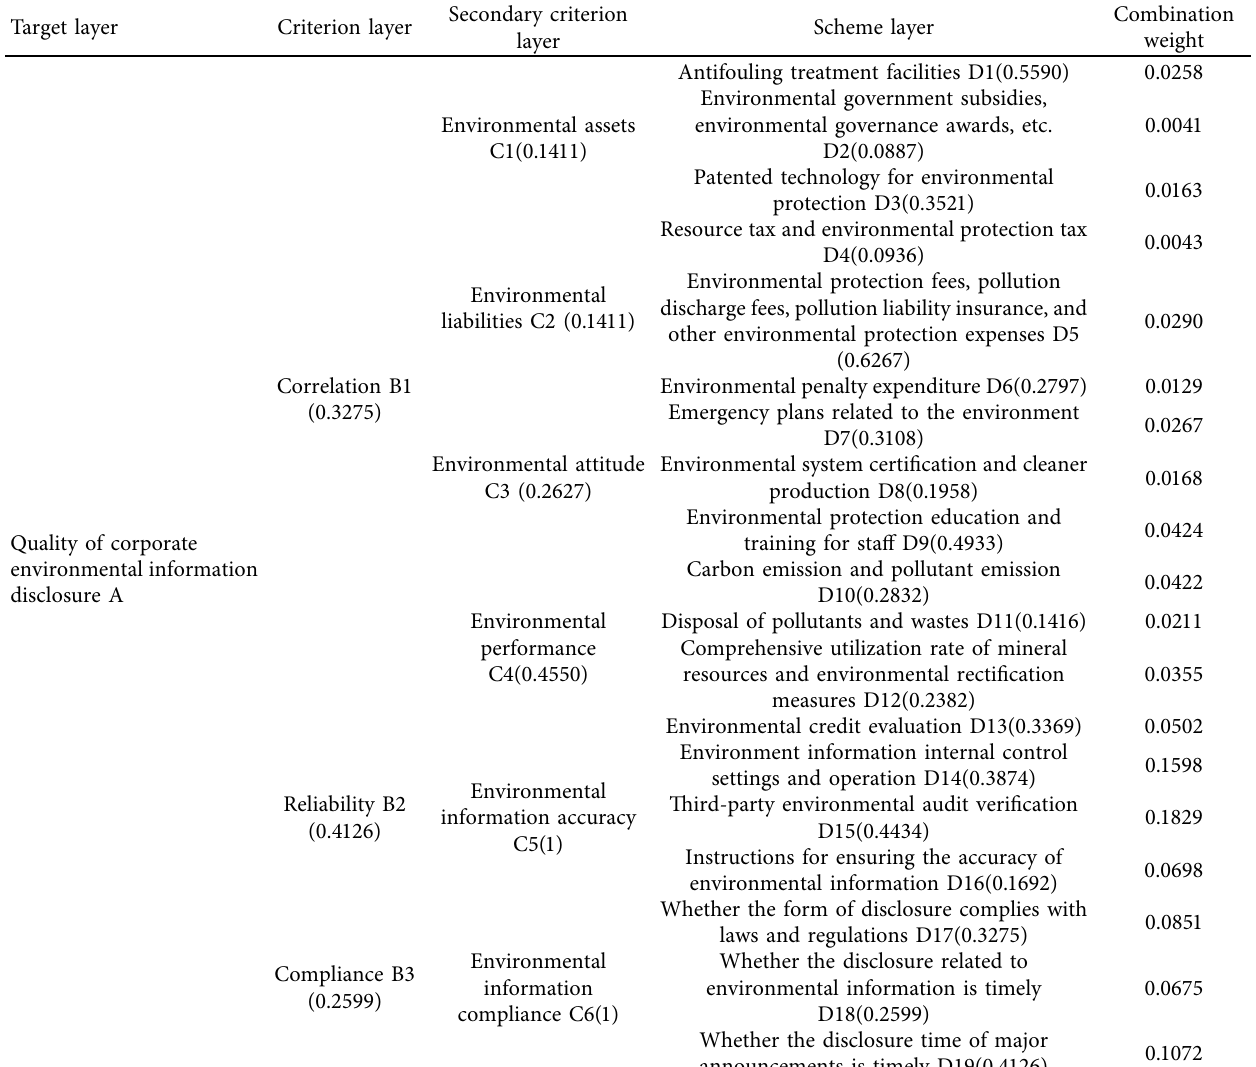
Table 11: Weight table of environmental accounting information disclosure quality index